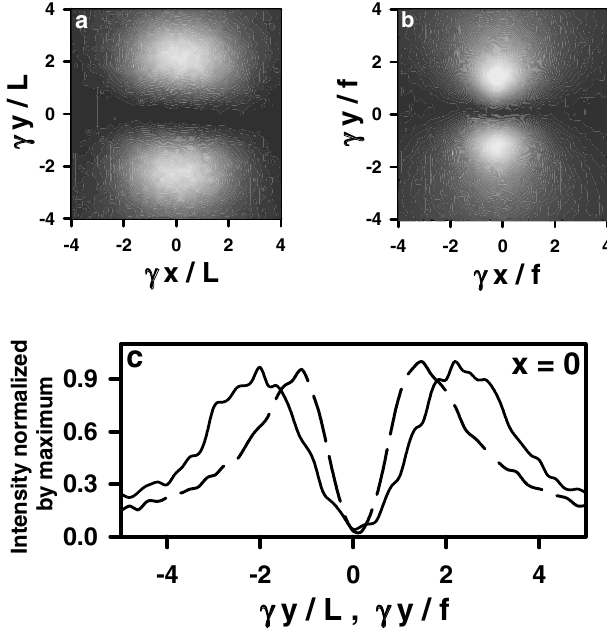
FIG. 16. Vertical polarization component of the OTR spatial distribution measured without (a) and with (b) the lens ( f (cid:5) 0 : 2 m ). (c) 2D OTR distributions in the plane x (cid:5) 0 measured without (solid line) and with (dashed line) the lens. An optical filter was removed during these